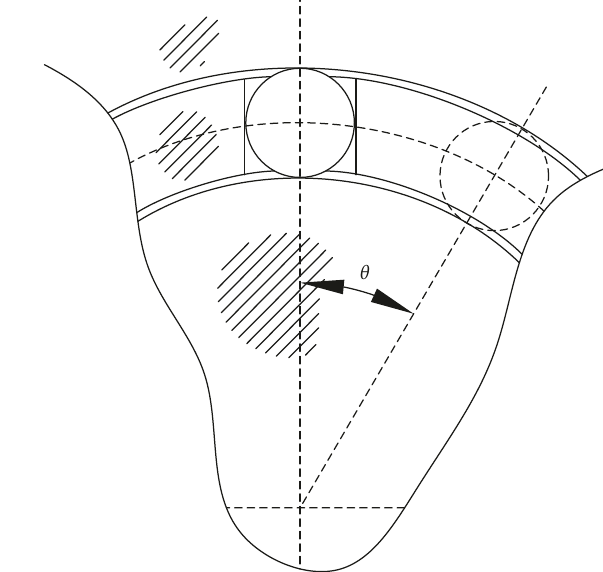
Figure 3: Motion of the roller.